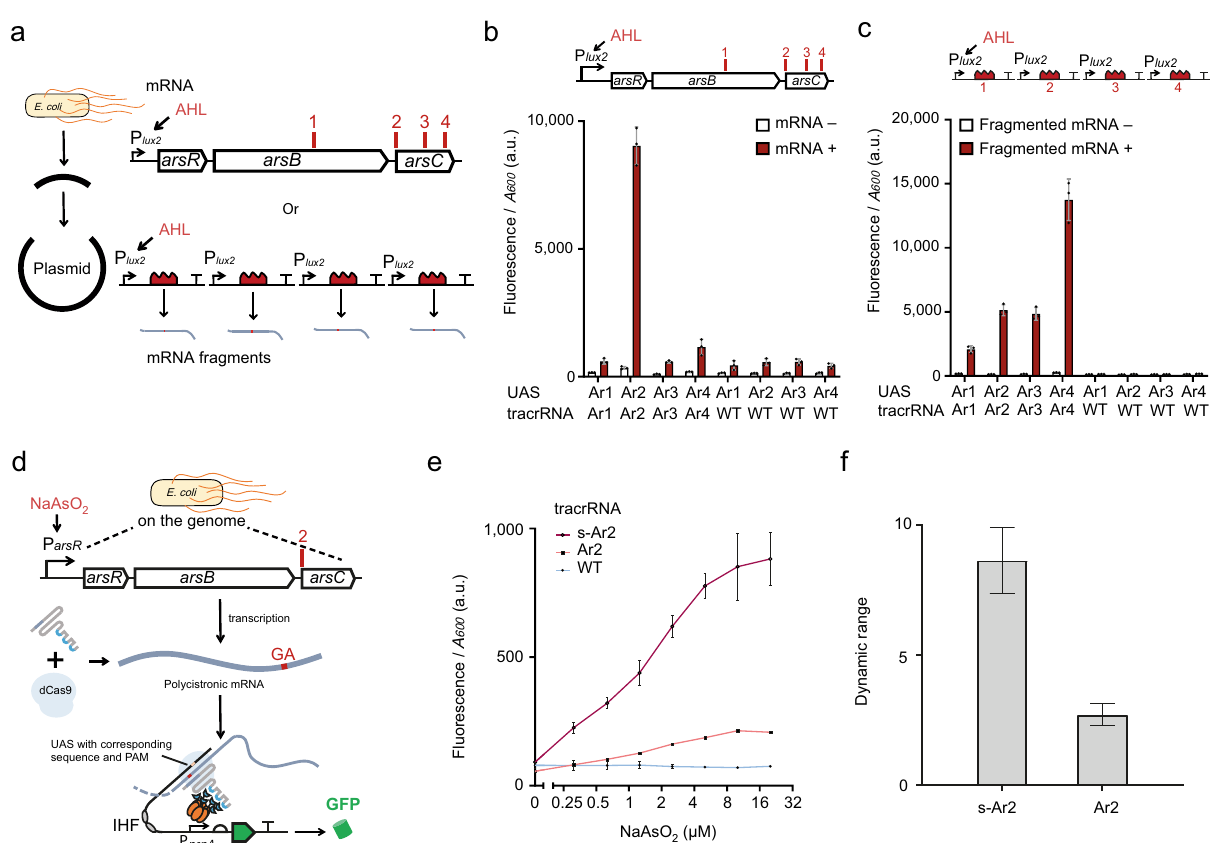
Fig. 4 Hijacking of endogenous mRNA as crRNA to detect arsenic induced transcription. a Schematic showing the sites selected for tracrRNA targeting. The DNA encoding the endogenous arsenic responsive pathway in E. coli was isolated and inserted into a plasmid under P lux2 promoter. In parallel, the four candidate sites were also extracted separately and inserted into the same vector backbone. The red numbers and short lines show positions of the four candidate sites (Ar1-Ar4). b Test of the availability of the candidate sites on the plasmid transcribed mRNA. The mRNA expressed by the P lux2 promoter was bound to different tracrRNA and corresponding promoters. Error bars, mean values + / − s.d. ( n = 3). c Test of the availability of candidate sites on the fragmented mRNAs as crRNAs. crRNAs expressed by the P lux2 promoter were bound to corresponding tracrRNAs and promoters. Inductions are the same as in b . Error bars, mean values + / − s.d. ( n = 3). d Schematic showing mechanism of hijacking the endogenous mRNA of the arsenic responsive operon of E. coli to activate reporter expression by CRISPRa. Red symbols indicate the Ar2 targeting site in the polycistronic mRNA of the arsenic-related gene cluster. The upstream RNA sequence immediately adjacent to the tracrRNA target site was used as the design template for the UAS for CRISPRa activation (see Supplementary Data 1). e CRISPRa outputs of hijacking endogenous mRNA as crRNA. ‘ Ar2 ’ stands for the sensor with originally designed tracrRNA. The ‘ s- Ar2 ’ stands for the sensor with 5 ’ -end truncated tracrRNA. ‘ WT ’ indicates that a WT tracrRNA which cannot match the mRNA used here. A gradient concentration of sodium arsenite (0, 0.31, 0.63, 1.3, 2.5, 5, 10, 20 μ M) was used for inducing transcription of the arsenic responsive gene cluster. Error bars, mean values + / − s.d. ( n = 3). f Dynamic range calculated from e . Error bars, mean values ± s.d. ( n = 3). a.u., arbitrary units. Source data are provided as a Source Data fi